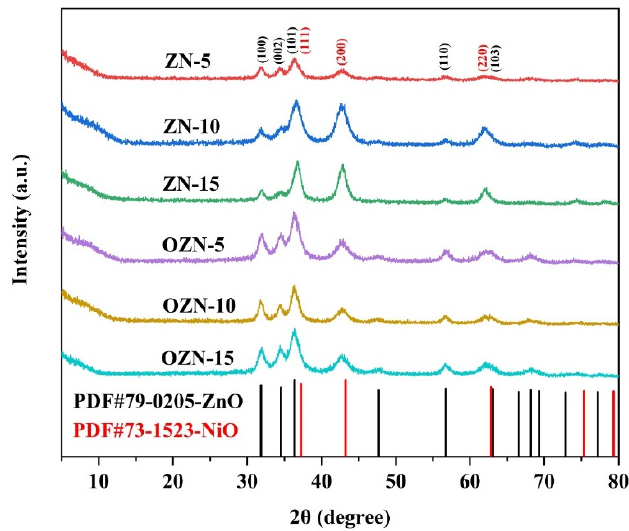
Figure 3. XRD patterns of different Ni content and oxygen vacancy addition.